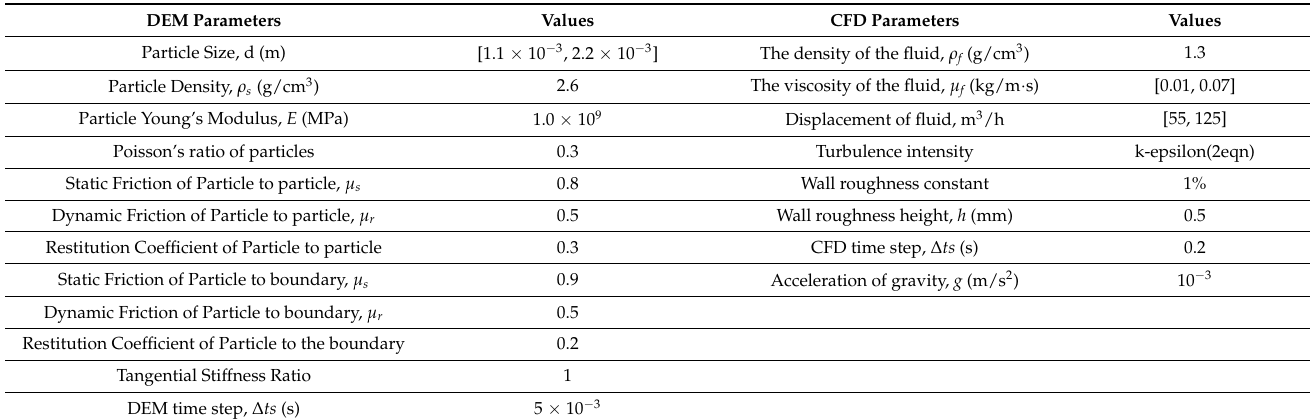
Table 1. Input parameters of DEM-CFD numerical